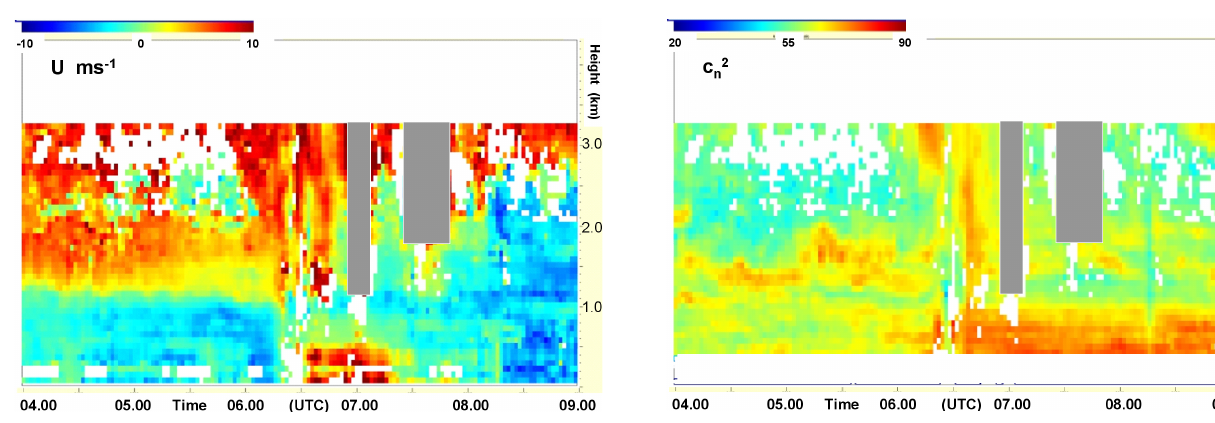
Fig. 4a. Wind U component measured by the wind profiler at Linkenholt 24 June 2005, 04:00 to 09:00UTC from 75 to 3250m a.g.l.